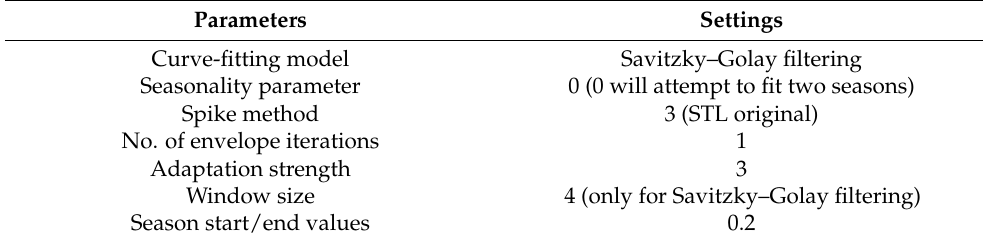
Table 1. Optimal parameter setting for curve fitting model. Parameters Settings Curve-fitting